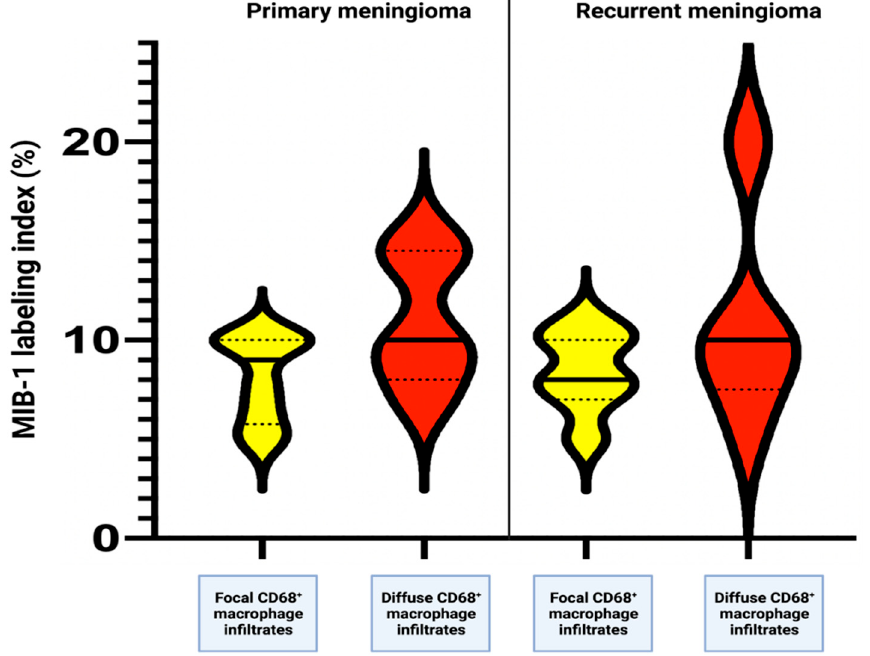
Figure 7. Violin plots displaying MIB-1 labeling index ( n = 16) in patients with focal (yellow) or diffuse (red) CD68 + macrophage infiltrates in primary and their corresponding recurrent meningiomas.